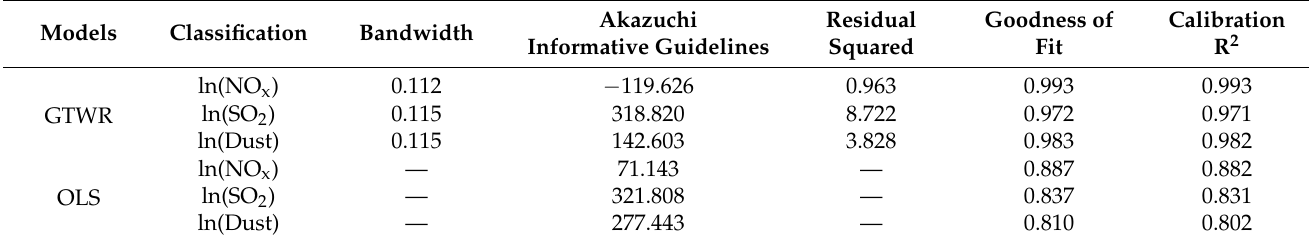
Table 3. Related parameters of the geographically and temporally weighted regression (GTWR)